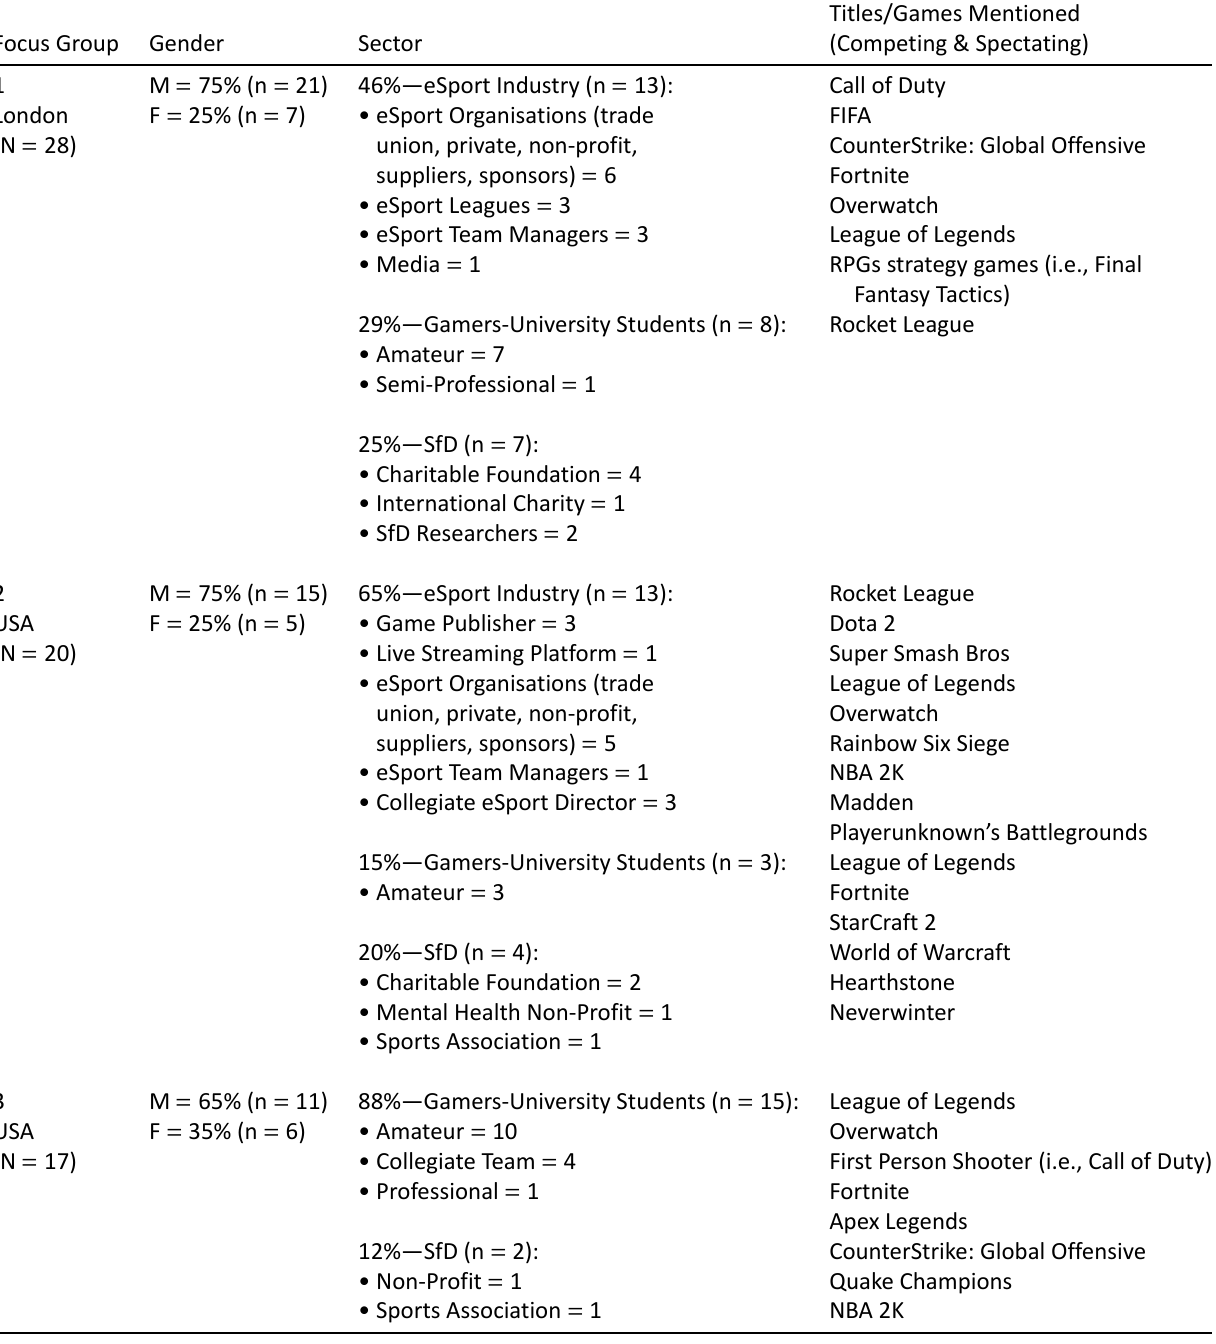
Table 1. Focus group